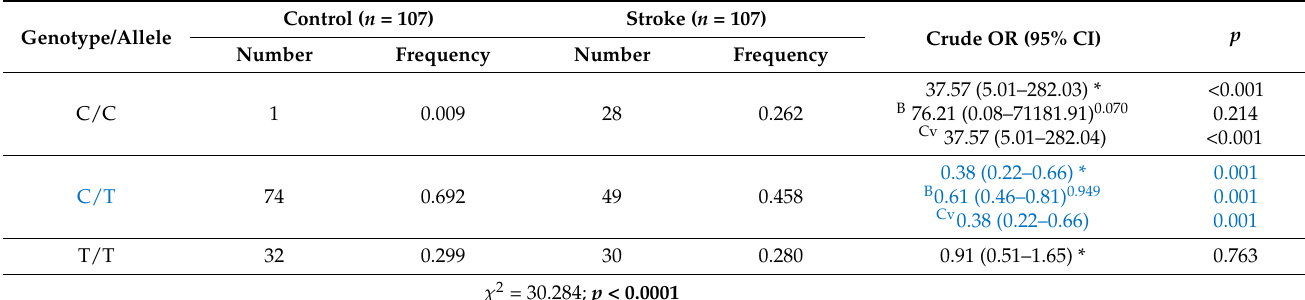
Table 5. Distribution of genotypes and alleles of the g.117803515C > T (rs1879417) polymorphism in the NOS1 gene and odds ratios (ORs) with 95% confidence intervals (95% CIs) in patients with stroke and